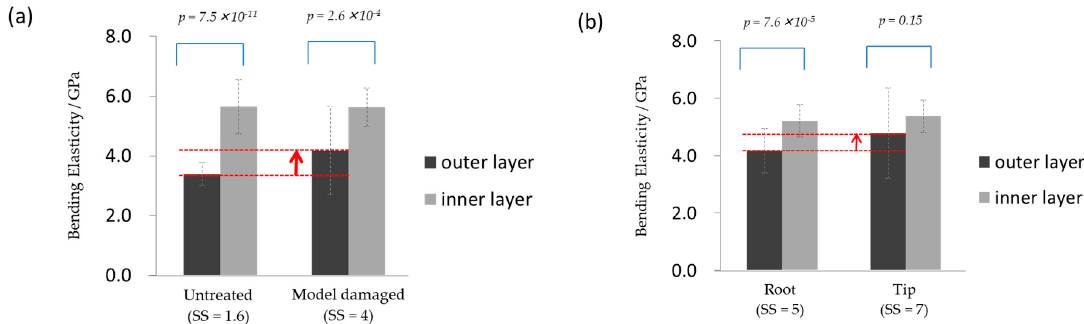
Figure 7. Bending elasticity of the outer and inner layers of healthy hair and damaged hair: ( a ) hair (Table 1; No. 1) and model damaged hair (Table 1; No.1). ( b ) Root and tip of heavily damaged hair. Measurements at 20 ◦ C and 65% relative humidity (RH), n = 20, SS = sensory